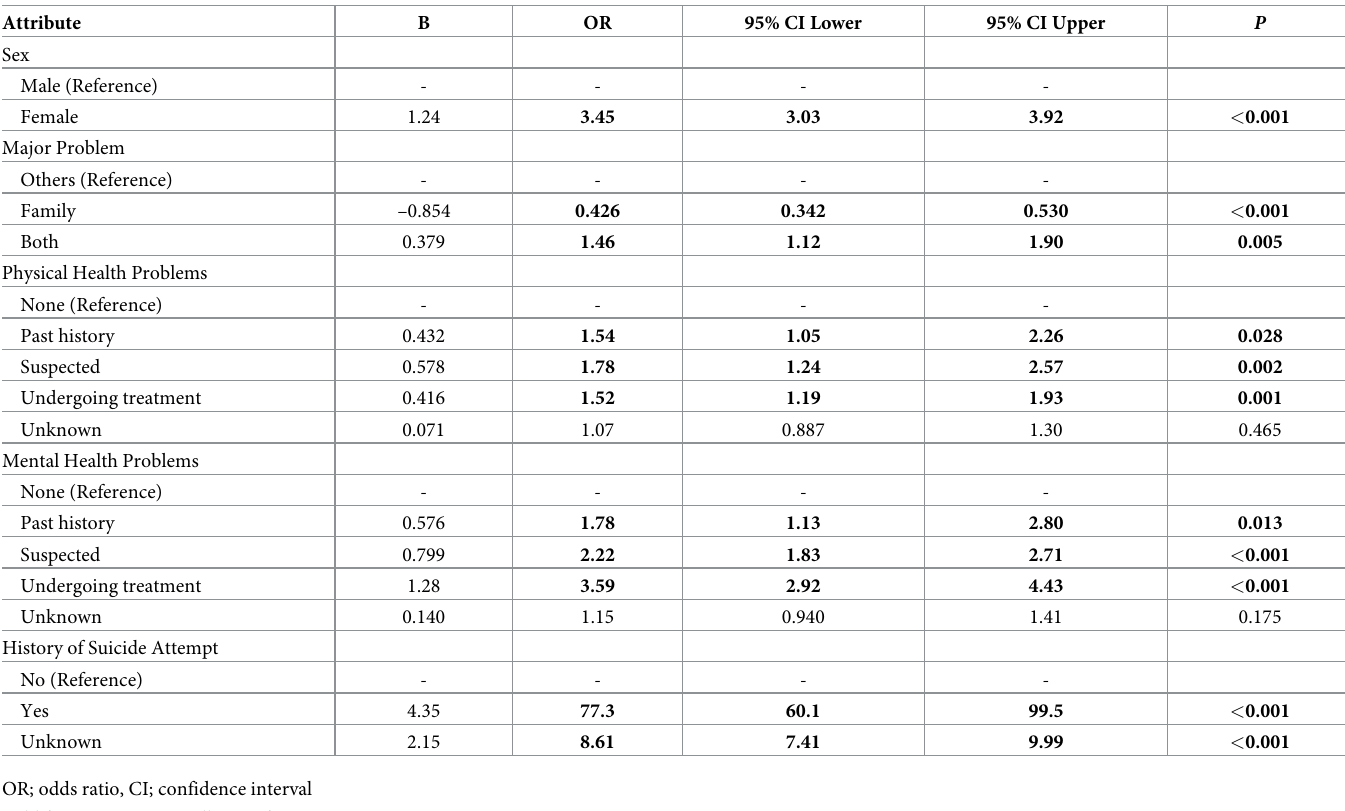
Table 4. Binominal Logistic Regression of Suicidal Ideation (N =